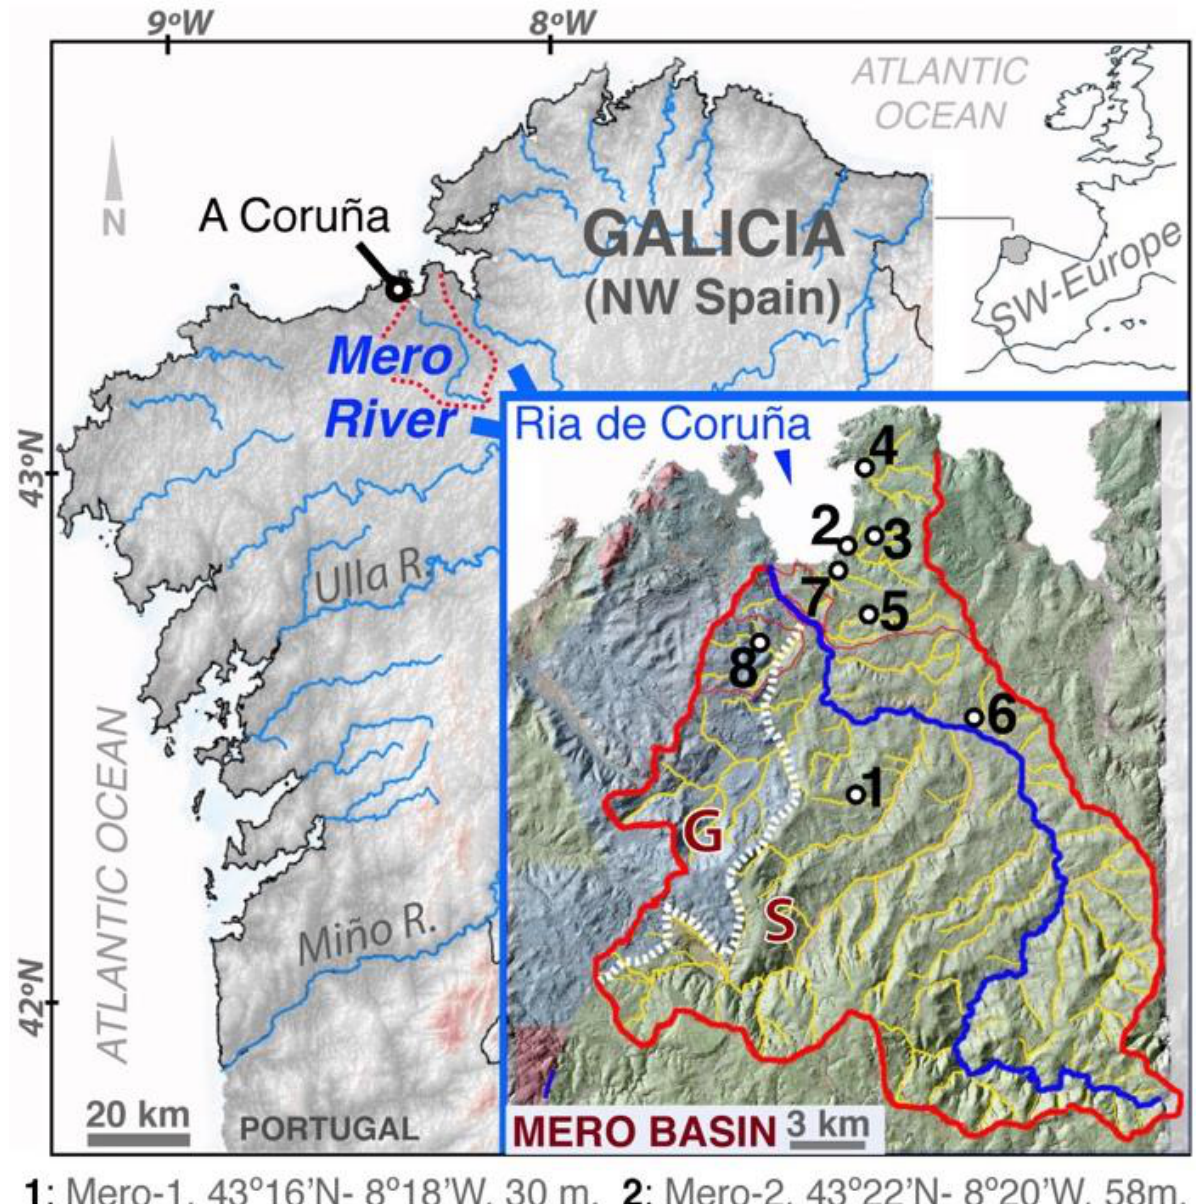
Figure 1. Atlantic coast of Galicia (NW Spain) and the alluvial deposits studied in the Mero Basin and Ria de Coruña. S: Metasediments (green area); G: granitoids (blue area). (1, 2 . . . 8): Mero samples, UTM (WGS84) coordinates and relative height (m).